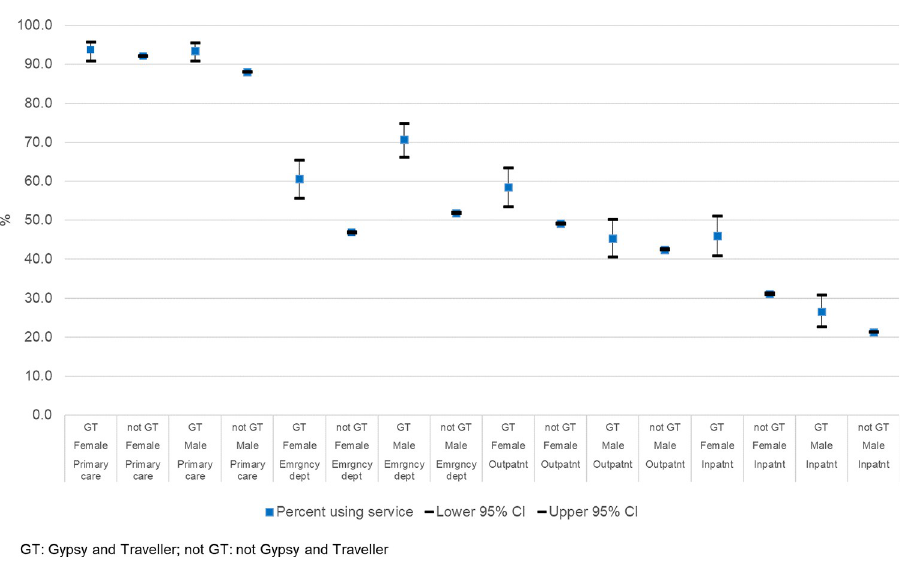
Fig 3. Observed unadjusted proportion with service contacts for any